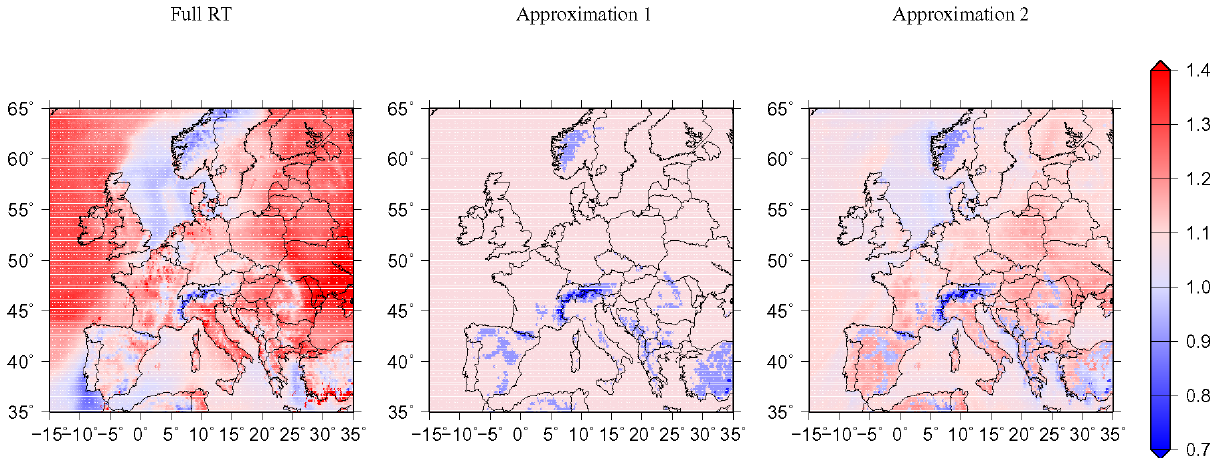
Fig. 3. Distribution over Europe of the DOFs surface-6km for full RT (left panel), approximation 1 (central panel) and 2 (right panel), for the 20 August 2009, 09:00UTC.